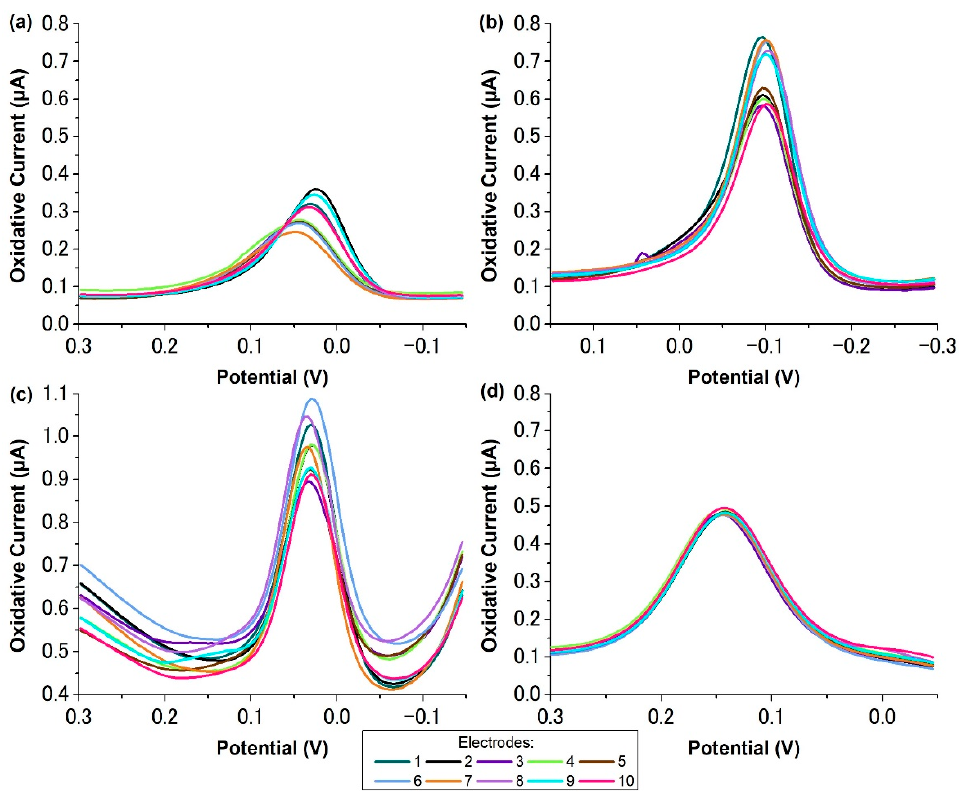
Figure 4. SWVs of ( a ) 25 μ M PAP at pH 7 on ten different CSPEs, ( b ) 25 μ M PAP at pH 9 on ten different CSPEs, ( c ) 25 μ M PAP at pH 7 on ten different GSPEs, and ( d ) 25 μ M FcMeOH on ten different CSPEs.